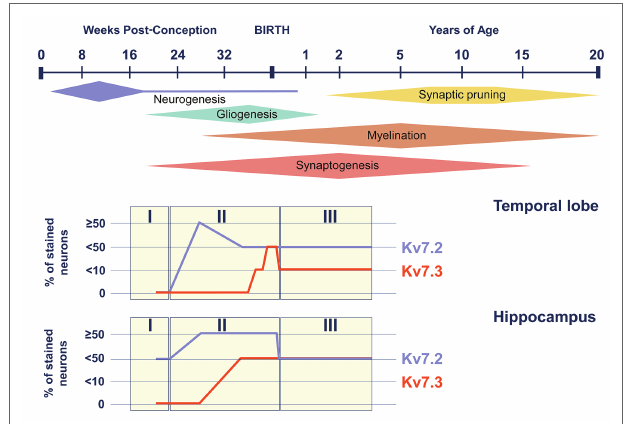
FIGURE 3 | Kv7.2 and Kv7.3 expression during human brain development. Top, timeline of key neural developmental cellular processes in the human brain (adapted from Semple et al., 2013). Bottom, representation of Kv7.2 and Kv7.3 positive neurons in the temporal lobe and the hippocampus during the three neurodevelopmental phases (adapted from Kanaumi et al.,